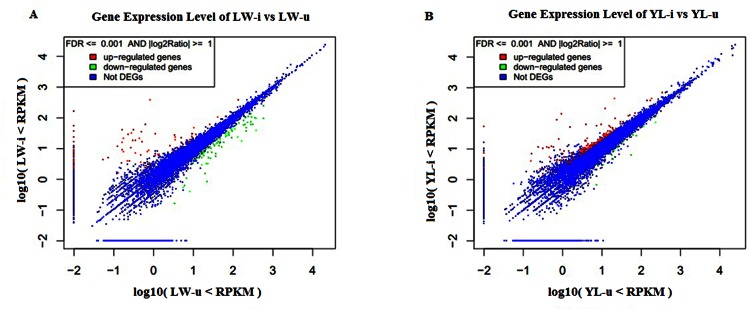
Comparison of gene expression levels in the lung tissues between the LW-i and LW-u (A) and YL-i and YL-u (B) libraries. The X and Y-axes show the mRNA expression levels in the two samples. Up-regulated and down-regulated genes were shown in red and green, respectively. Blue dots represent genes with similar expression levels.